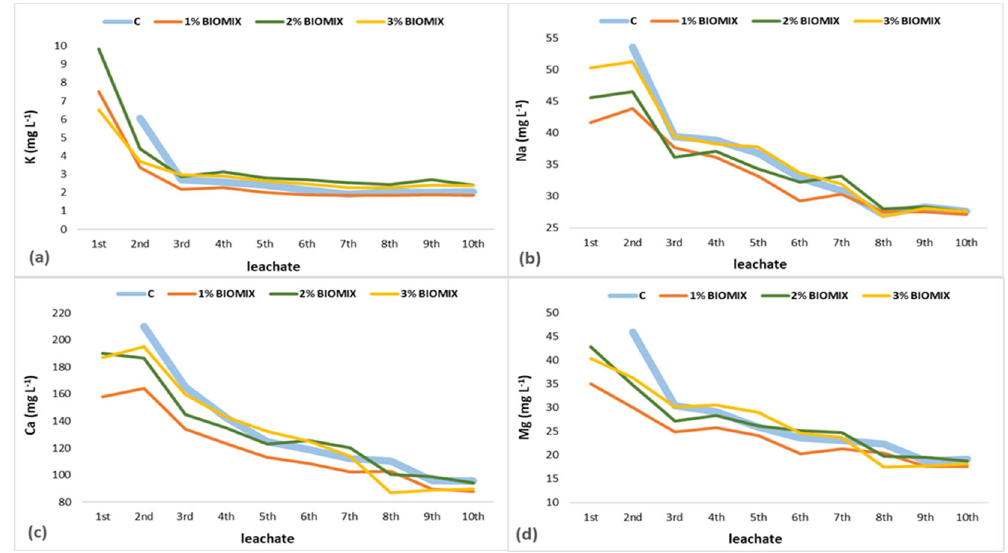
Figure 3. Changes of: ( a ) K (mg/L) concentrations, ( b ) Na (mg/L) concentrations, ( c ) Ca (mg/L) concentrations and ( d ) Mg (mg/L) concentrations in the leachates of the 10 irrigation applications of the four treatments. Each value is the mean of three replicates.